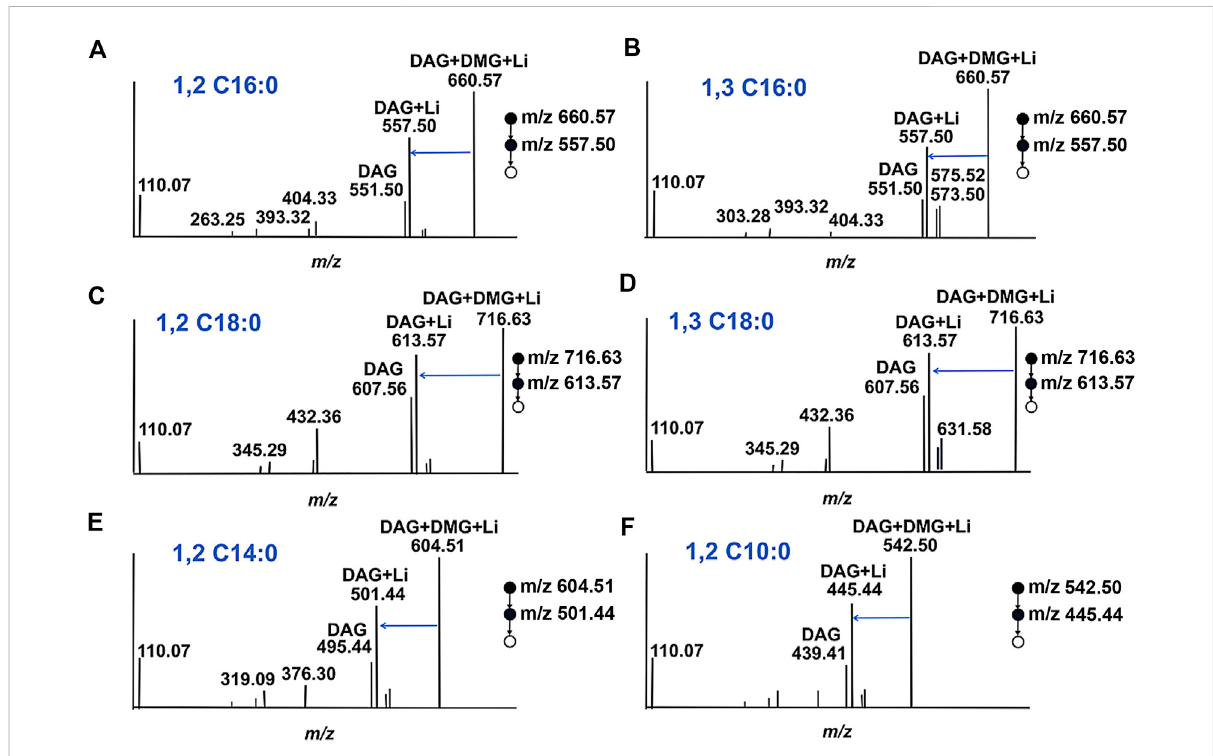
FIGURE 3 Proposed structures for fragments resulting from CID of DMG -DAGs. (A) DAG 16:0/16:0/0; (B) DAG 16:0/0/16:0; (C) DAG 18:0/18:0/0; (D) DAG 18:0/0/18:0; (E) DAG 14:0/14:0/0; (F) DAG